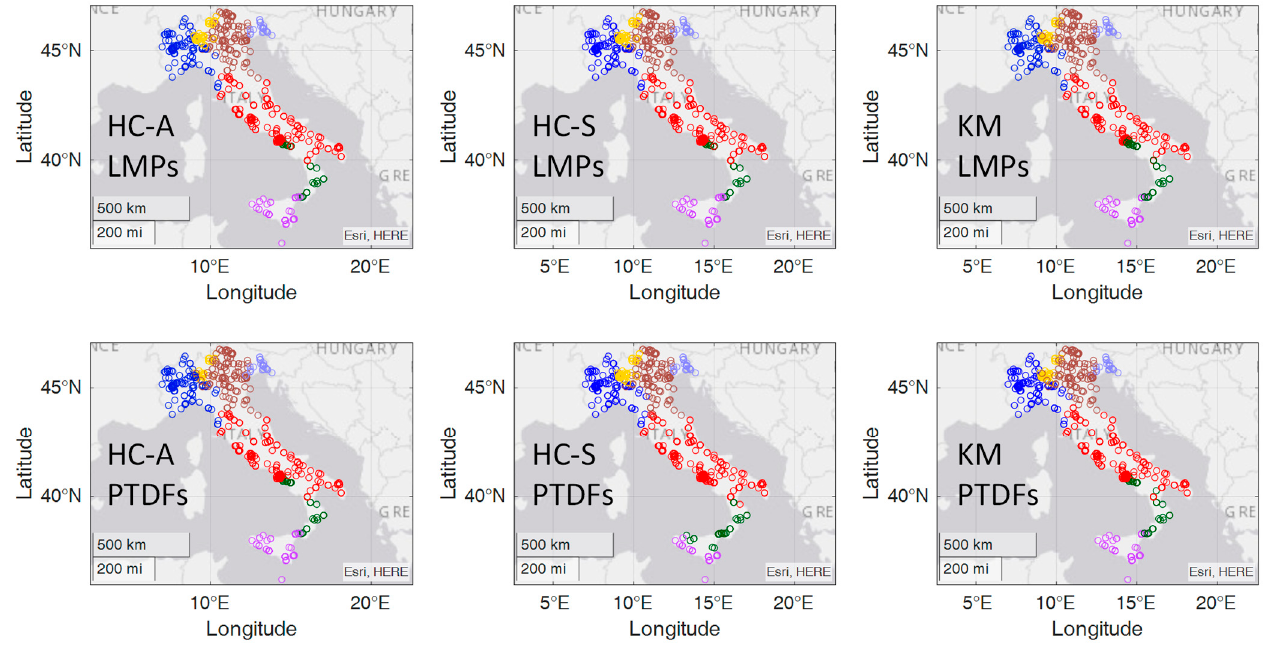
Figure 10. Comparison of the solutions with seven clusters obtained with the algorithm/feature pairs: HC-average/ LMP s (on the left) and KM/ PTDF s (on the right).